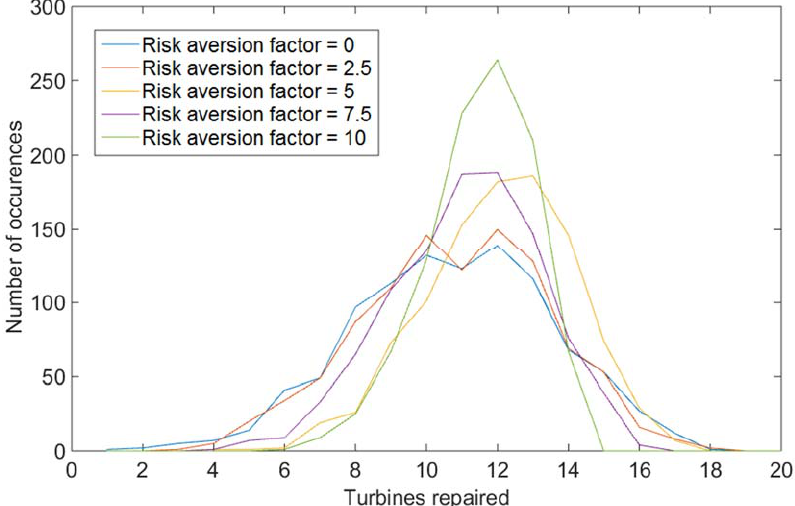
Figure 5. Breakdown of the Monte Carlo analysis for cases 1–5. Note that increasing the risk aversion factor favours less ‘risky’ policies.